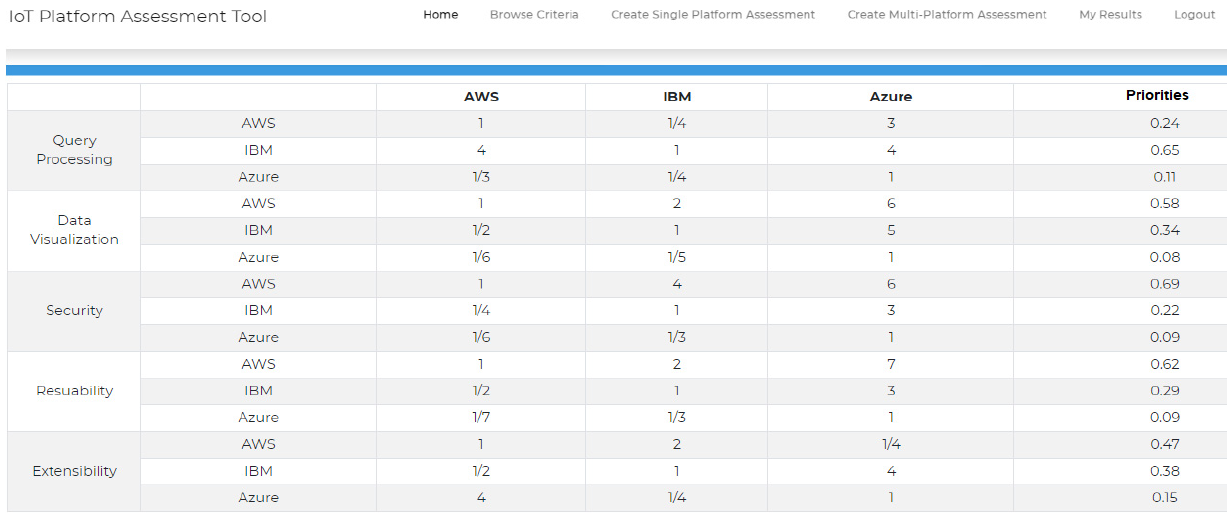
Figure 7. Priority vectors for the IoT platforms.